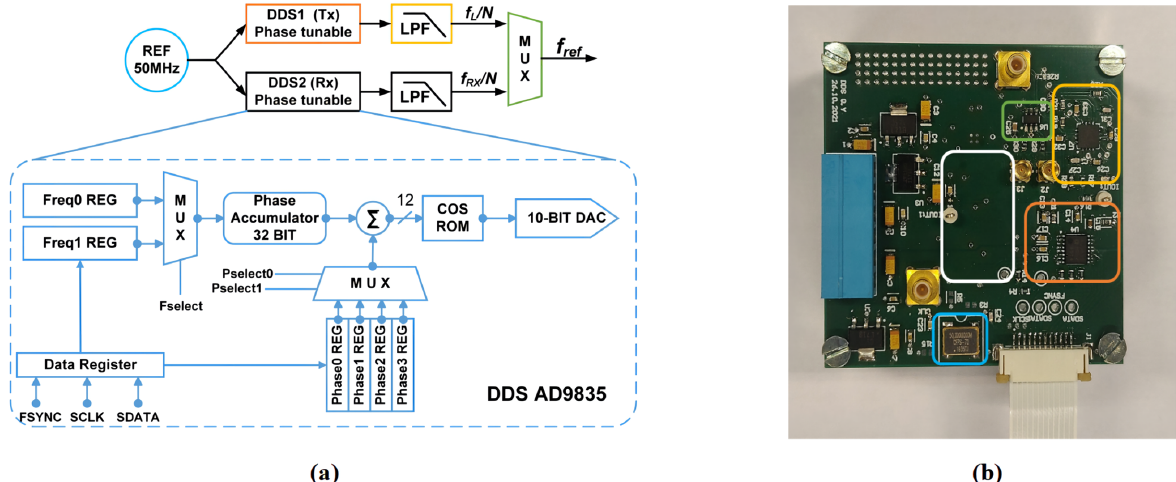
Figure 4. (a) Block diagram of the proposed DDS reference generator and (b) its PCB-based implementation on a 56 × 57mm two-layer PCB. Corresponding blocks are highlighted with the same color in the block diagram and the PCB photograph. The white rectangle indicates the position of the second DDS module on the bottom layer of the